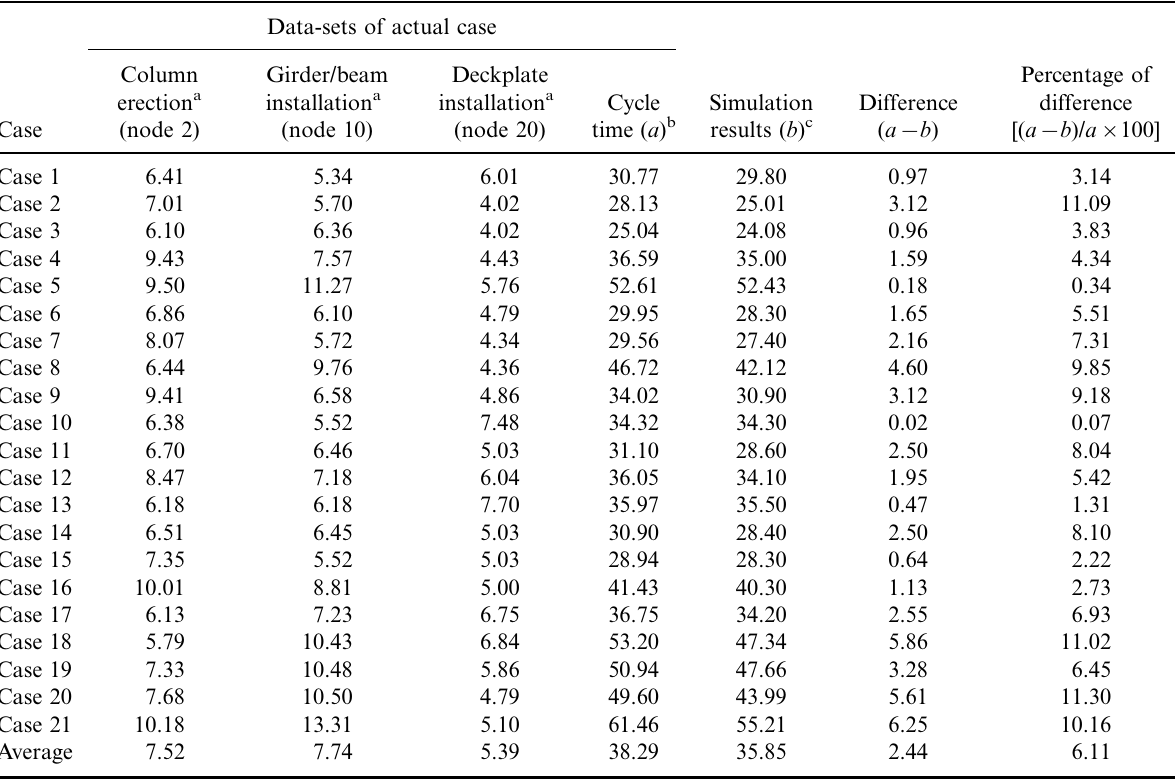
Table 2. Report of actual data-set and simulation results Data-sets of actual case